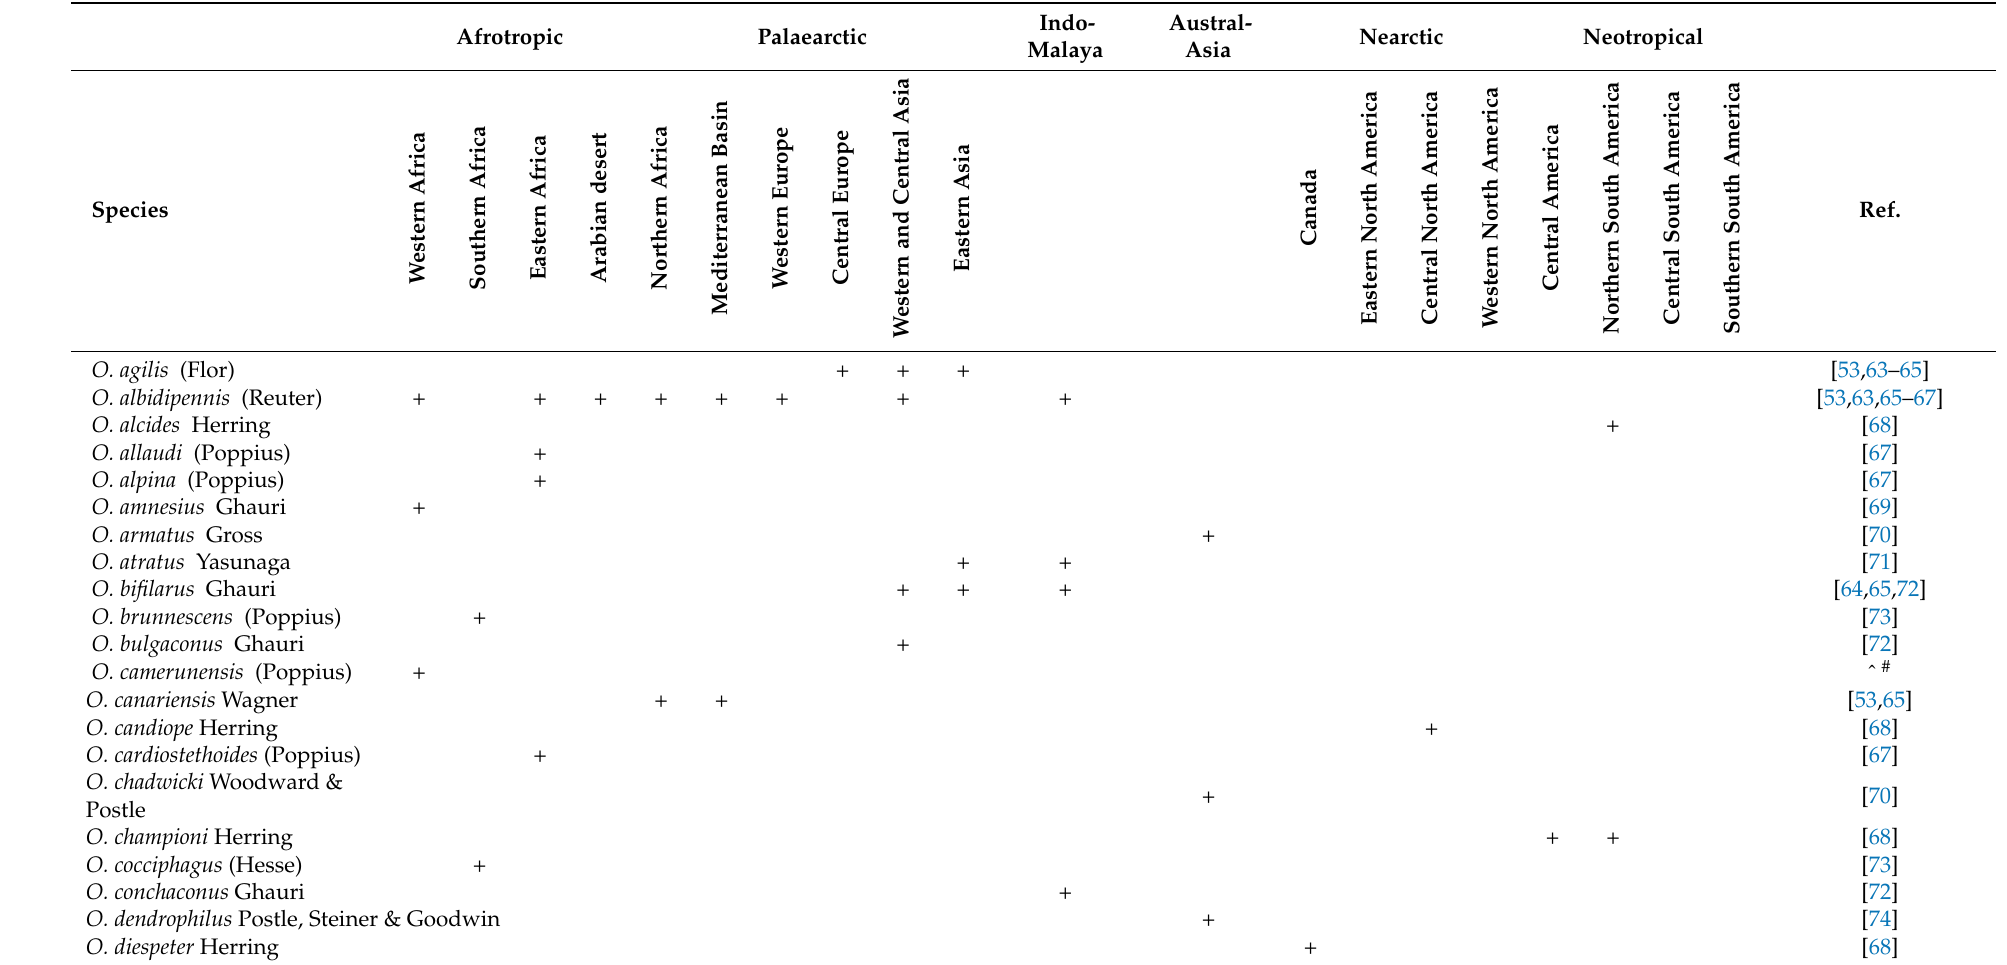
Table 2. Zoogeographic distribution of Orius species (Heteroptera: Anthocoridae).